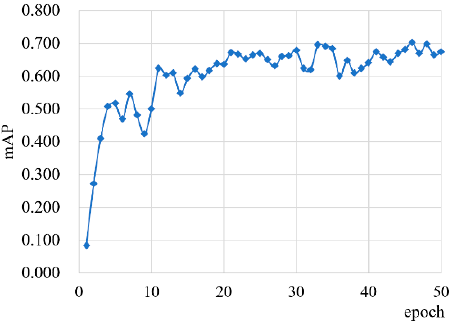
Figure 5. The mAP 50 of one ‐ class model on the test dataset at different training iterations.